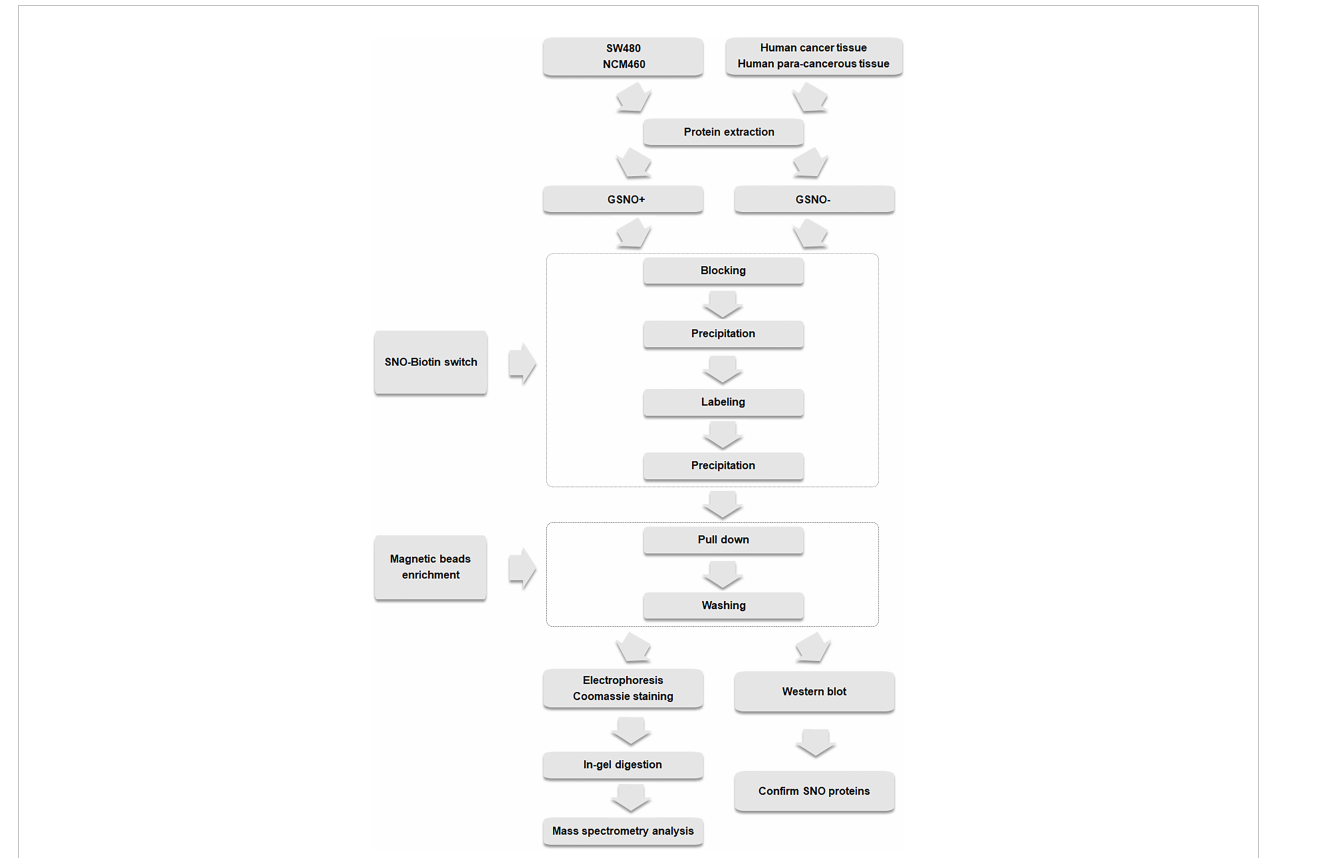
FIGURE 1 Experimental fl ow chart of biotin switch and magnetic bead enrichment of potential and endogenous SNO